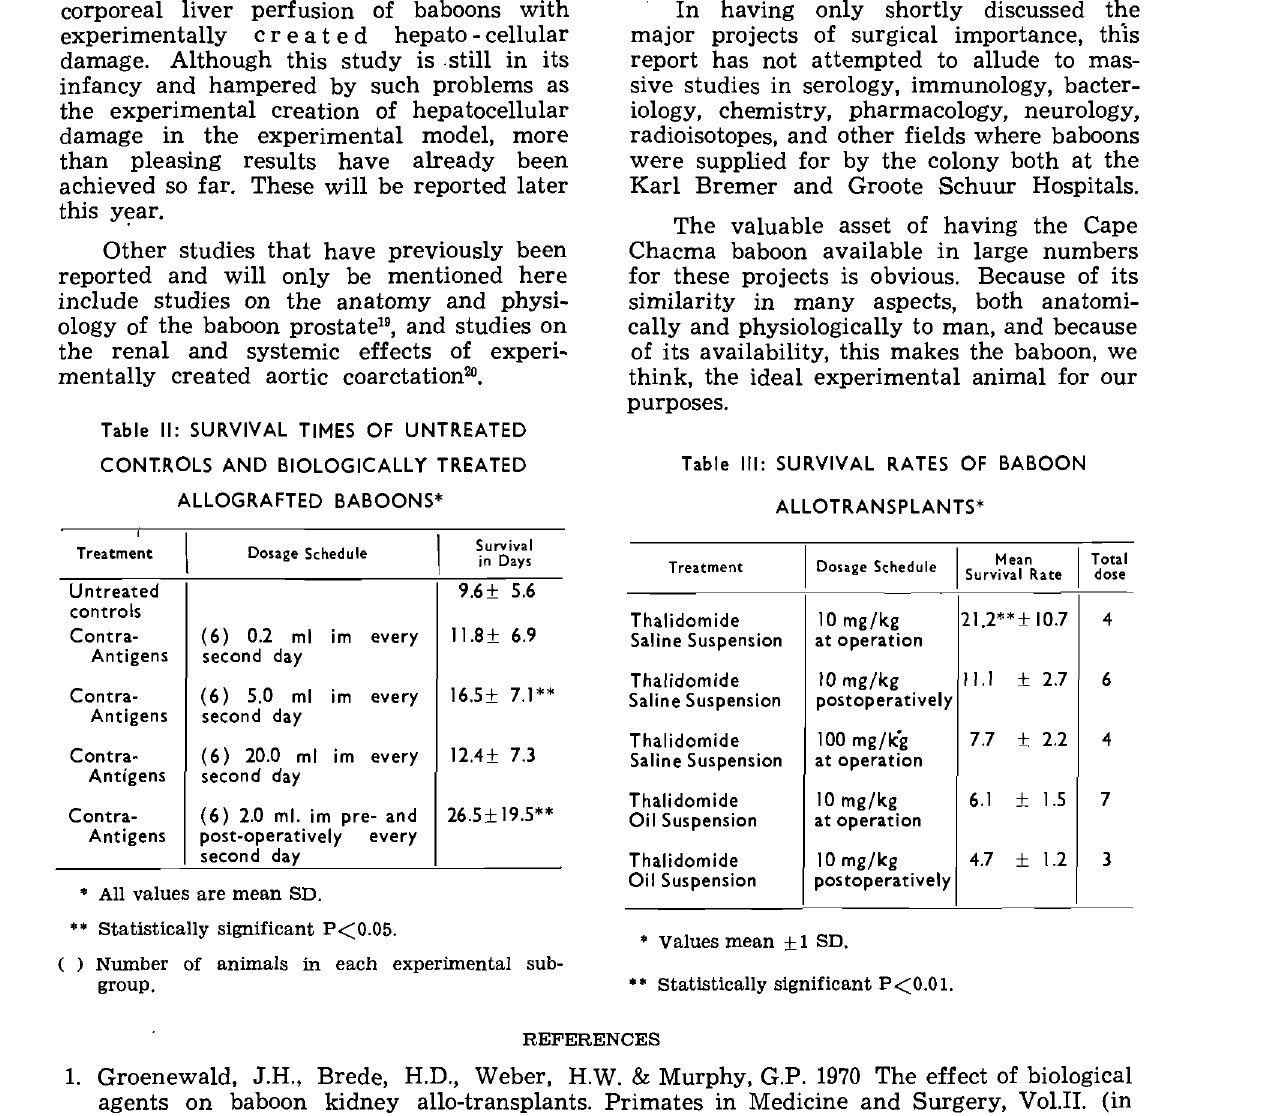
Table II: SURVIVAL TIMES OF UNTREATED CONT.ROLS AND BIOLOGICALLY TREATED ALLOGRAFTED BABOONS* Treatment